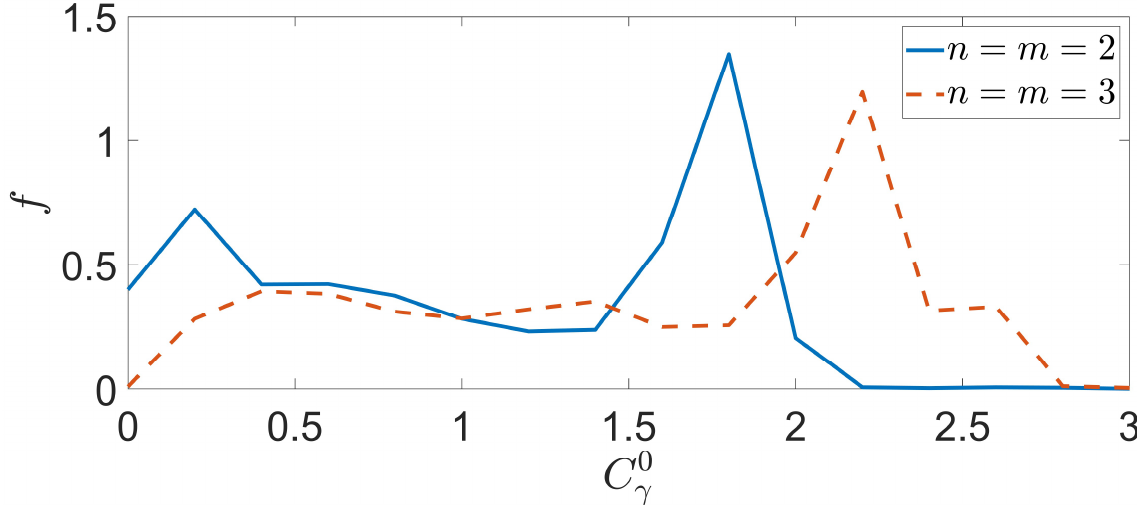
Figure 9. Probability Density Function of the observed coefficient C 0